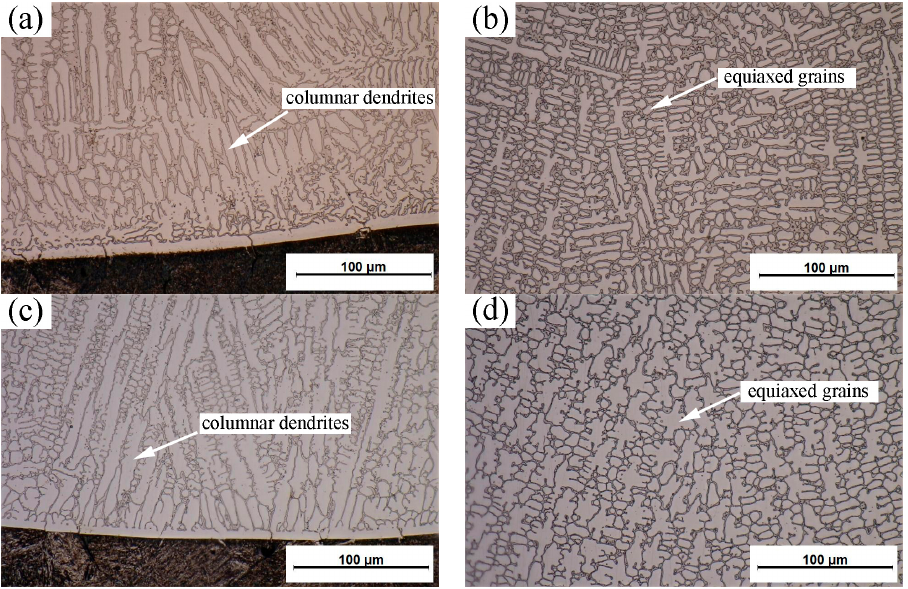
Figure 3. Optical micrographs of the cladding layer: ( a ) The bottom of NiCo00; ( b ) The middle of NiCo00; ( c ) The bottom of NiCo30; ( d ) The middle of NiCo30.